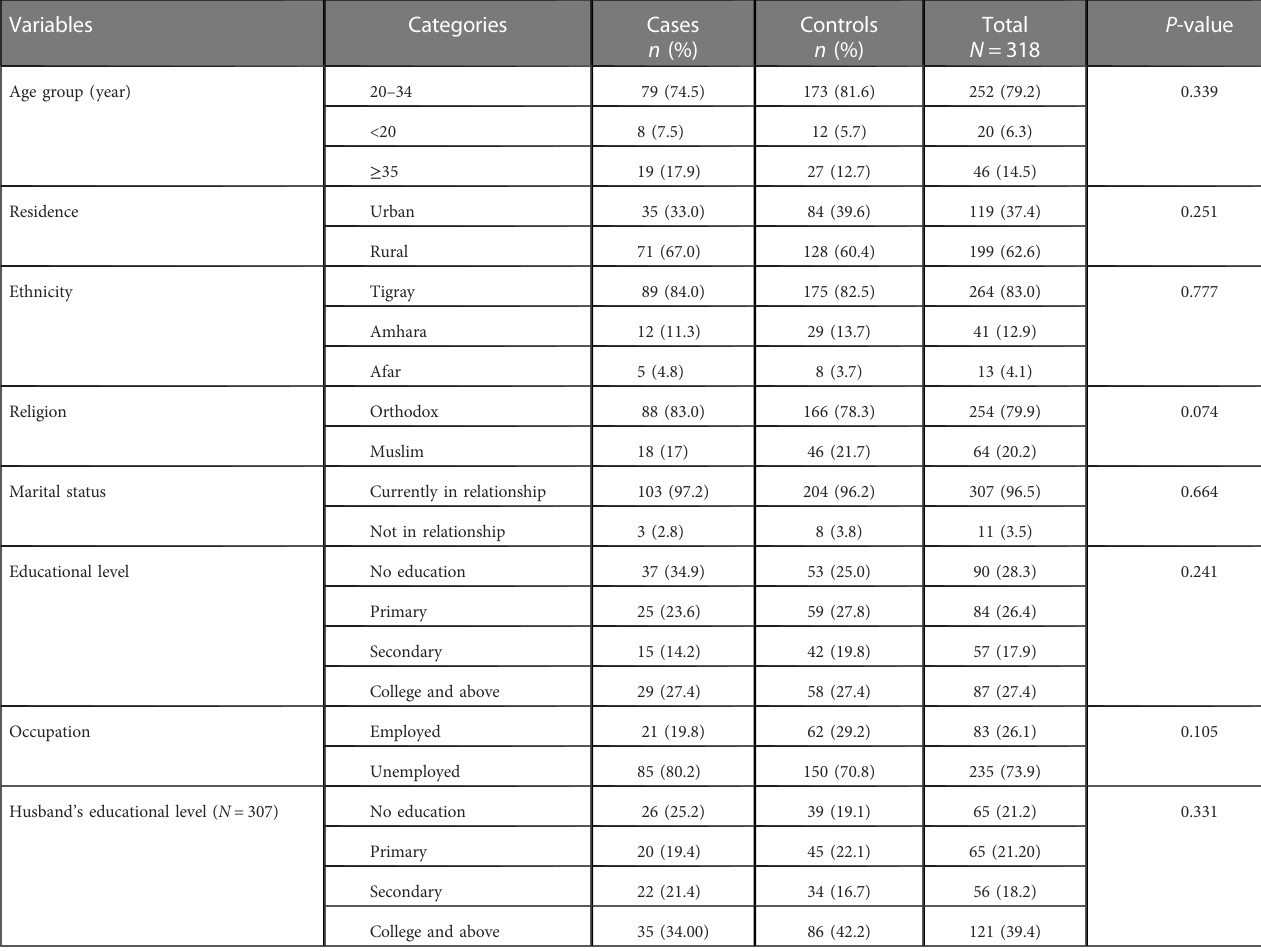
TABLE 1 Socio-demographic characteristics of study participants with and without primary postpartum hemorrhage in the public hospital of southern Tigray, Ethiopia, 2019.